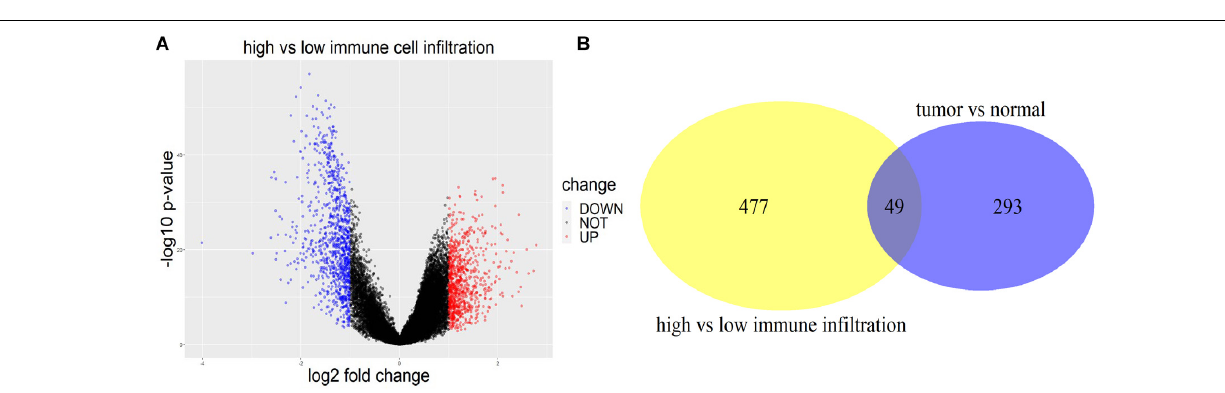
FIGURE 2 | DEGs between high and low immune infiltration groups, and between tumor and normal tissues. (A) The volcano plot of DEGs between the high immune-cell-infiltrated and low immune-cell-infiltrated group. Red indicated DEGs up-regulated in the high infiltration group, while blue indicated the down-regulated ones. (B) The yellow circle represented the DE lncRNAs between high and low immune infiltration groups. The purple circle represented the DE lncRNAs between tumor and normal tissues. Forty-nine lncRNAs appeared in both